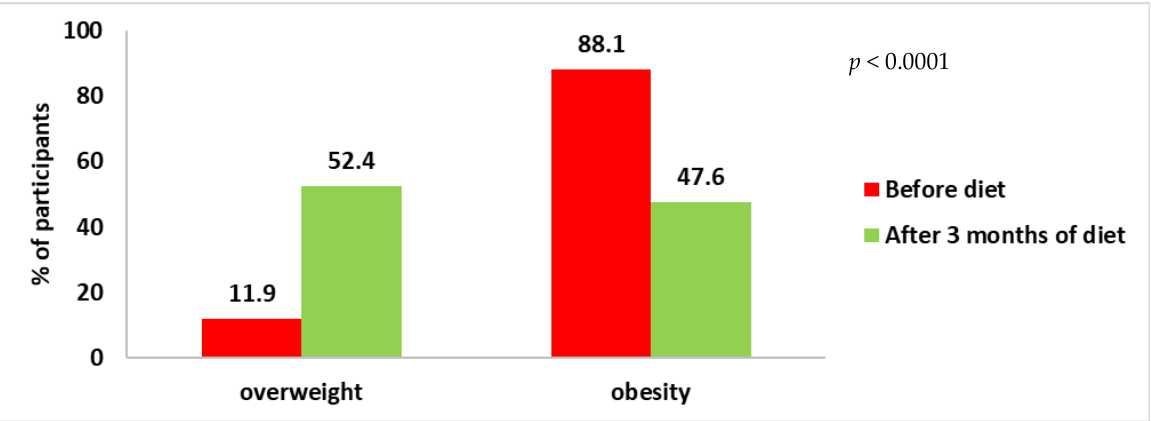
Figure 1. Classification of total female subjects according to BMI.